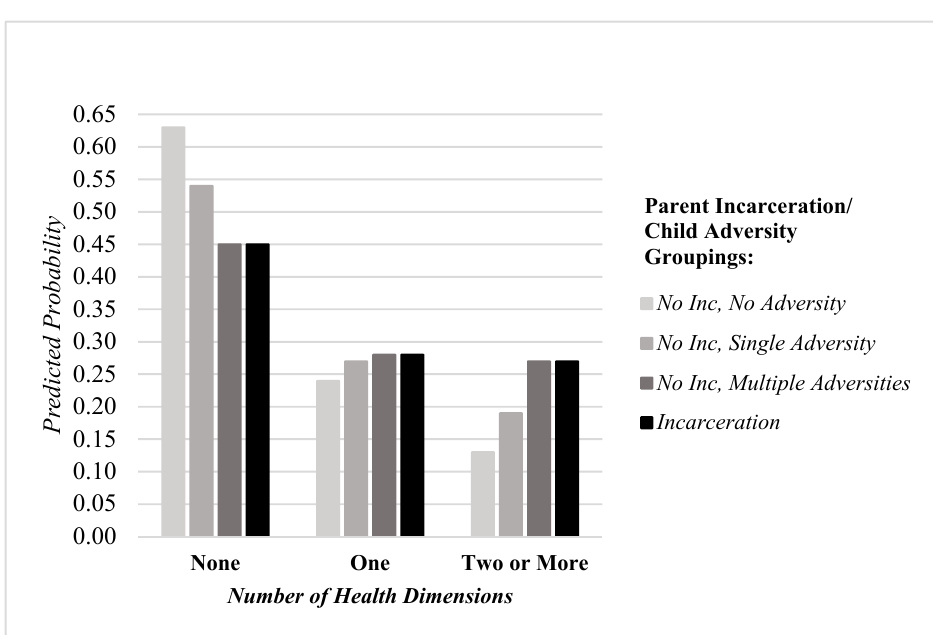
Figure 1. The Predicted Probability of Health Conditions across Dimensions at the Nexus of Incarceration and Child Adversities.